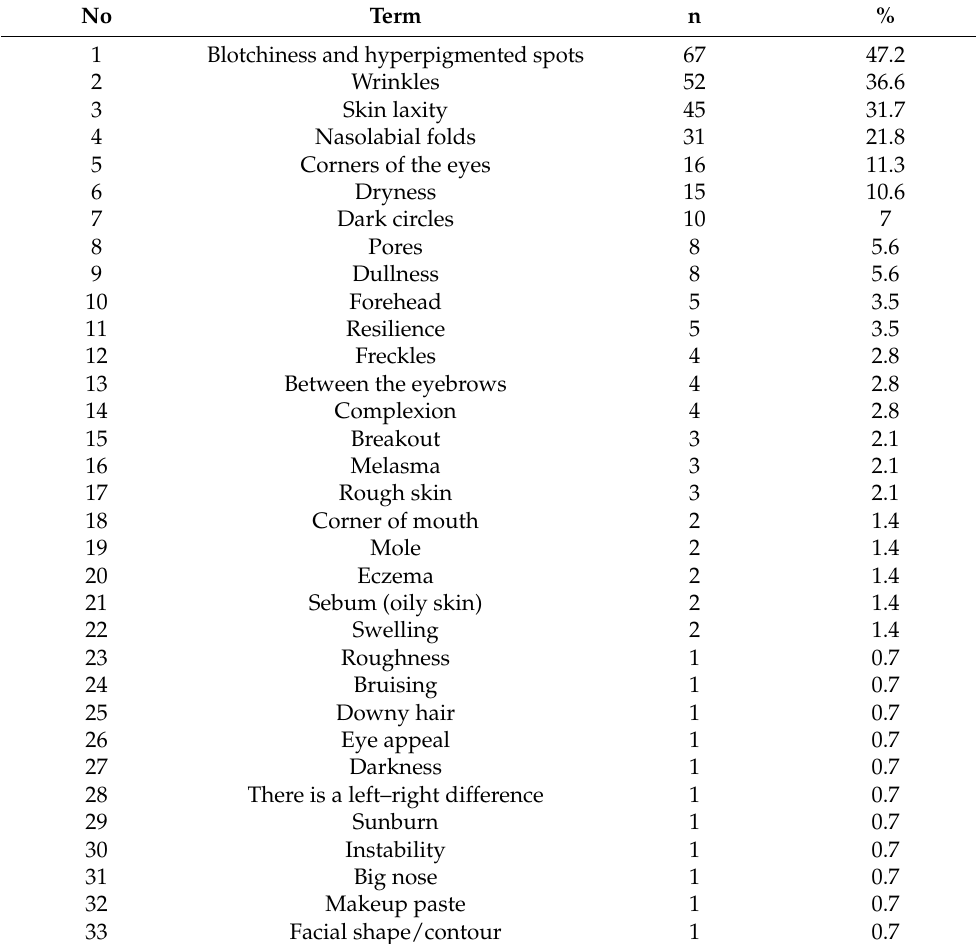
Table 2. Extracted terms from sentences in the stated concern regarding the facial